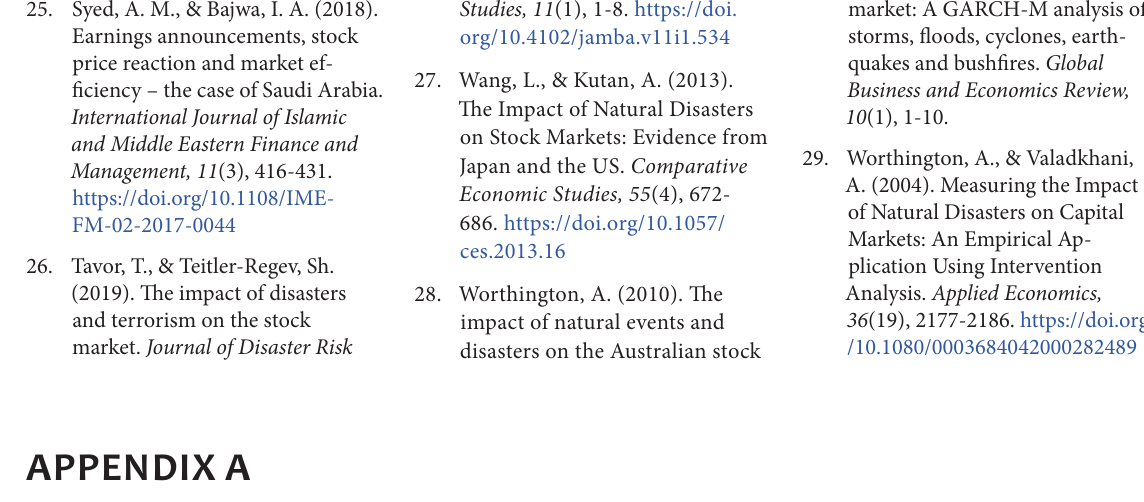
Table A1. The main economic force majeure events in Ukraine during 1991–2018